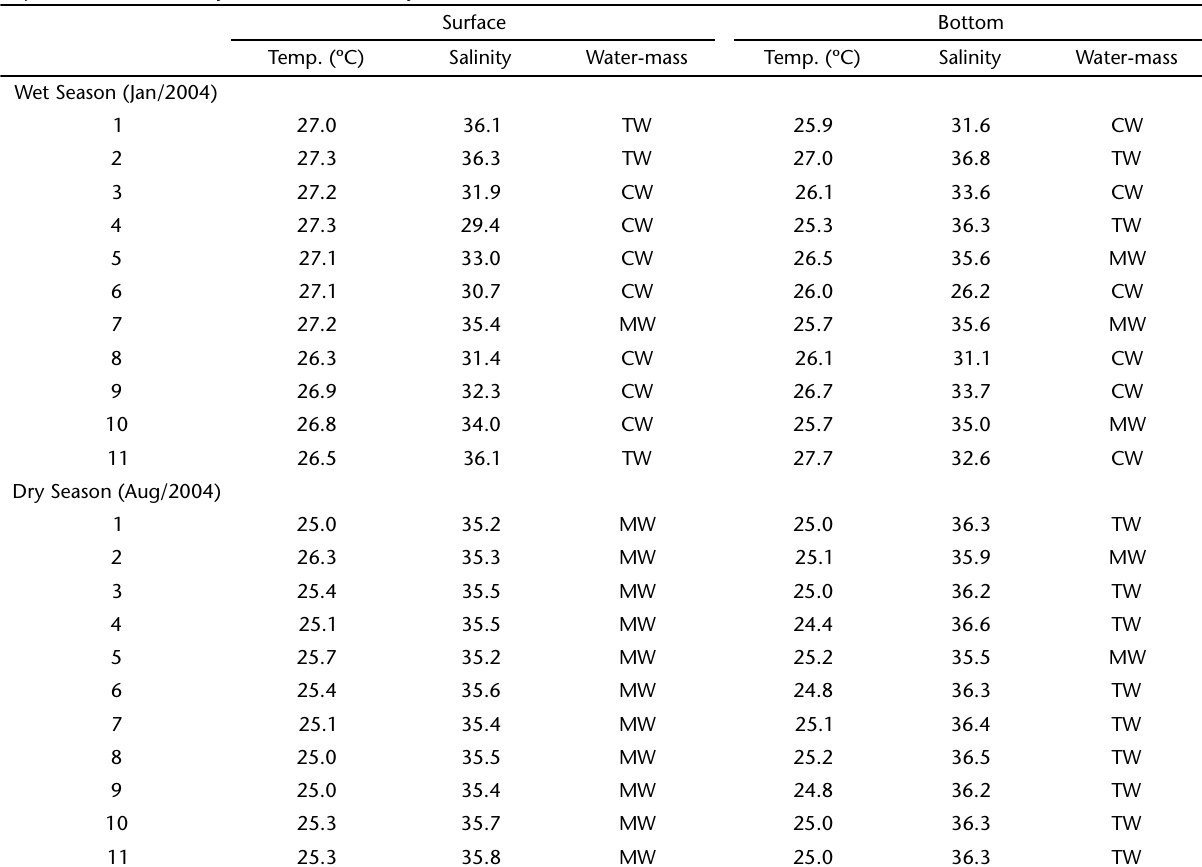
Table I. Temperature (ºC), salinity and water-mass classification during the wet and dry season of 2004 on the inner continental shelf adjacent to the coastal system of Camamu Bay. Surface Bottom Temp. (ºC) Salinity Water-mass Temp. (ºC) Salinity